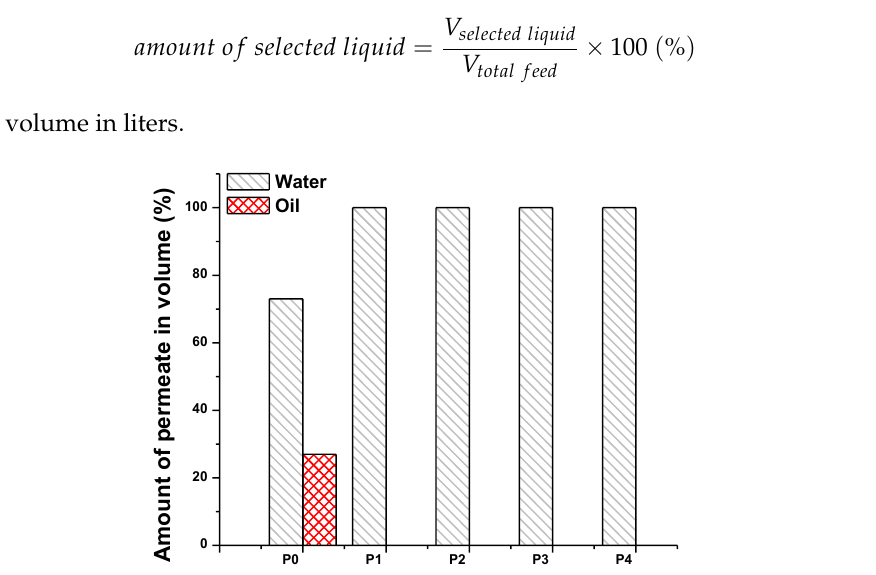
Figure 11. Selectivity of the membranes P0–P4.